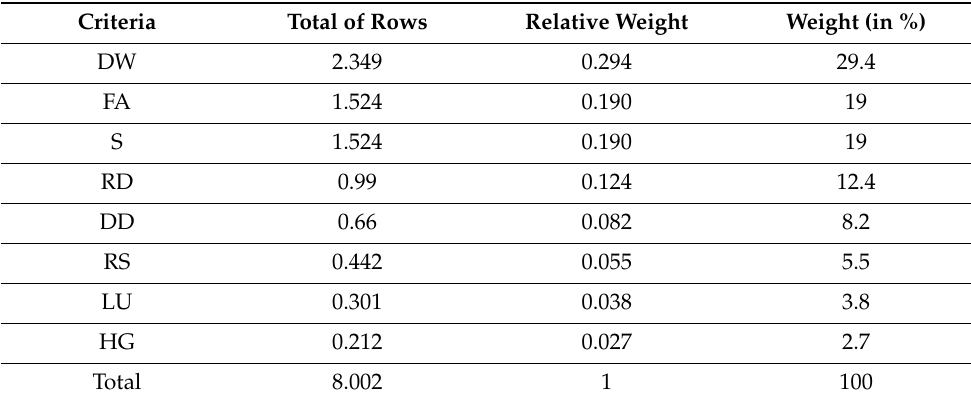
Table 10. Weights of the eight criteria of the study using the